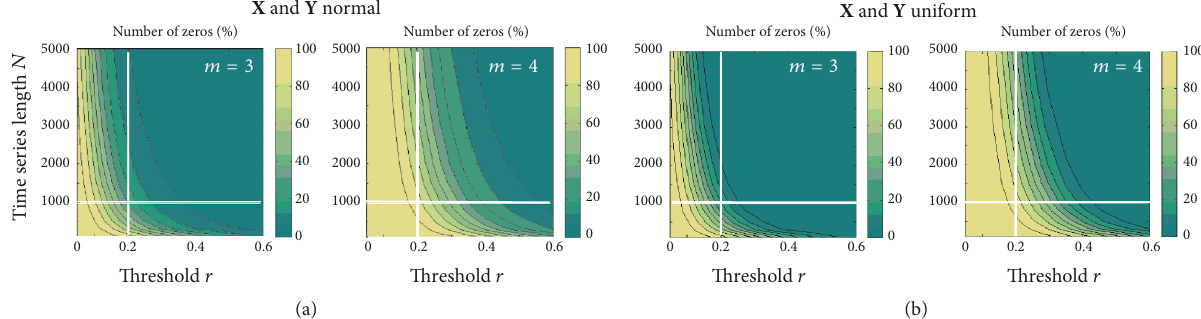
Figure 5: Number of ̂𝑝 𝑚 𝑖 (𝑟) = 0 estimates [ % ] in artificial data presented in threshold-length ( 𝑟 - 𝑁 ) plane for 𝑚 = 3 and 4; color changes from green (0% zero matches) to yellow (100% zero matches); (a) X and Y normally distributed; (b) X and Y uniformly distributed.